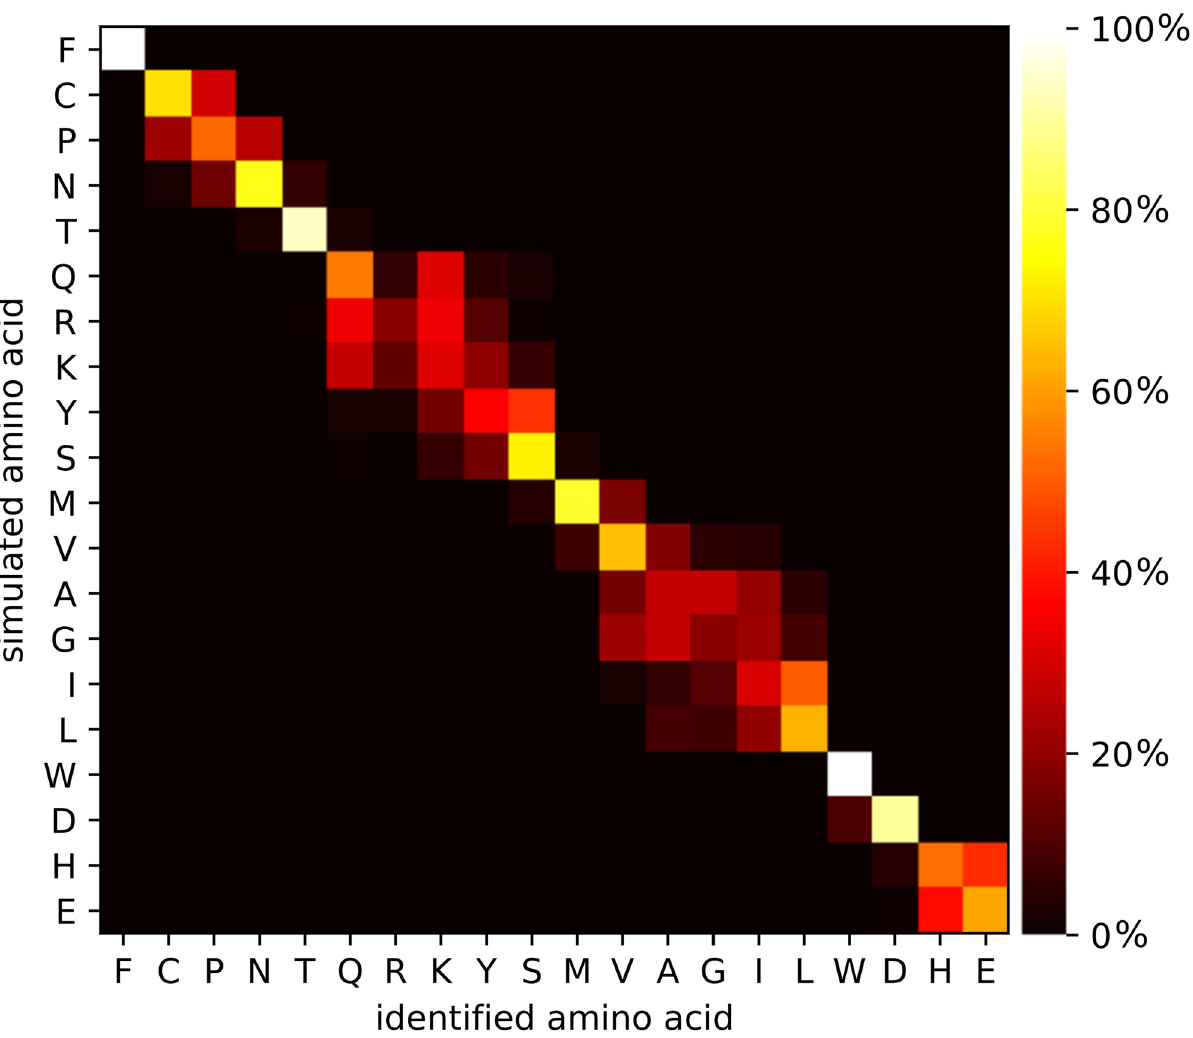
Fig 4. Heatmap for isolated amino acid identification. Each entry is the fraction of signals generated for that row’s amino acid identified as that column’s amino acid. The heatbar shows the interpretation of the colours in the heatmap as percentage of identifications. Sequencing simulations were done for the carboxyl terminal group, at pH 3.0, for 100 ms measurement time per terminal amino acid and an SNR of 10. The average identification accuracy is 59.90%. With 7 clusters (F, CPN, T, QRKYS, MVAGIL, WD, HE), the cluster identification accuracy is >